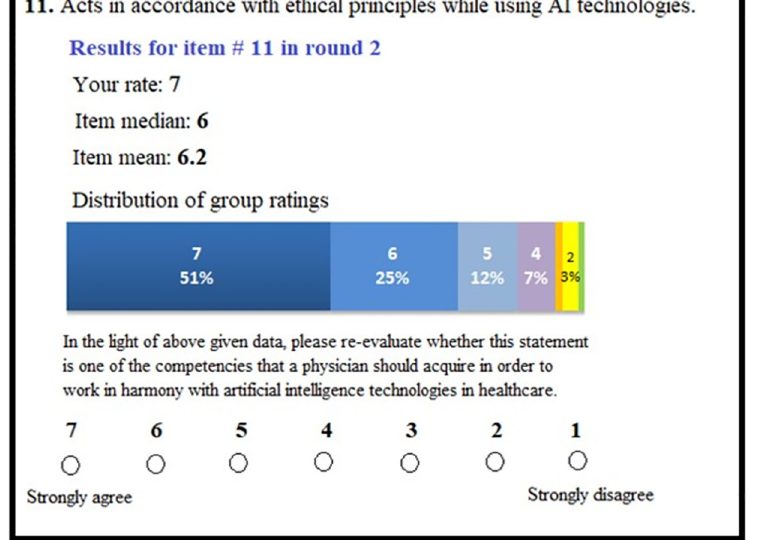
Fig 2. Example item presentation in Round 3 survey